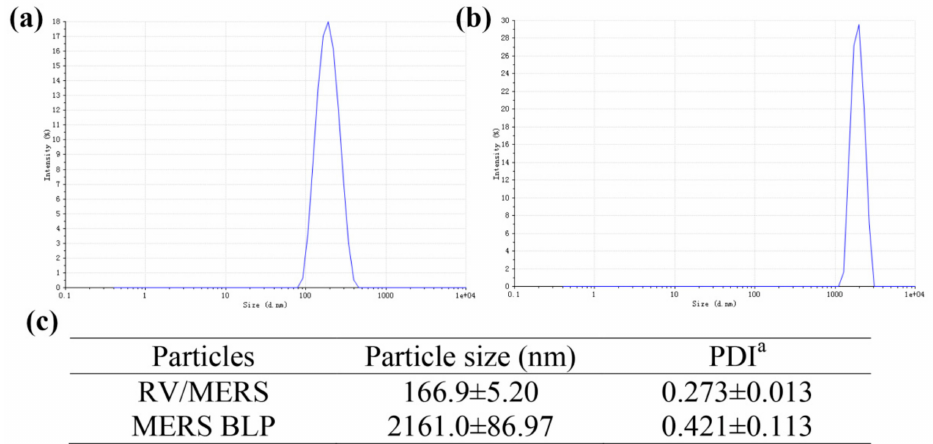
Figure 1. The particle size of recombinant RV expressing MERS-CoV S1 protein (RV / MERS) and MERS bacterium-like particle (MERS BLP). The particle size distribution of RV / MERS ( a ) and MERS BLP ( b ). The particle size and polydispersity index (PDI) of RV / MERS and MERS BLP ( c ). Data was shown as mean ± SD ( n = 3). a PDI, polydispersity index from dynamic light scattering (DLS).